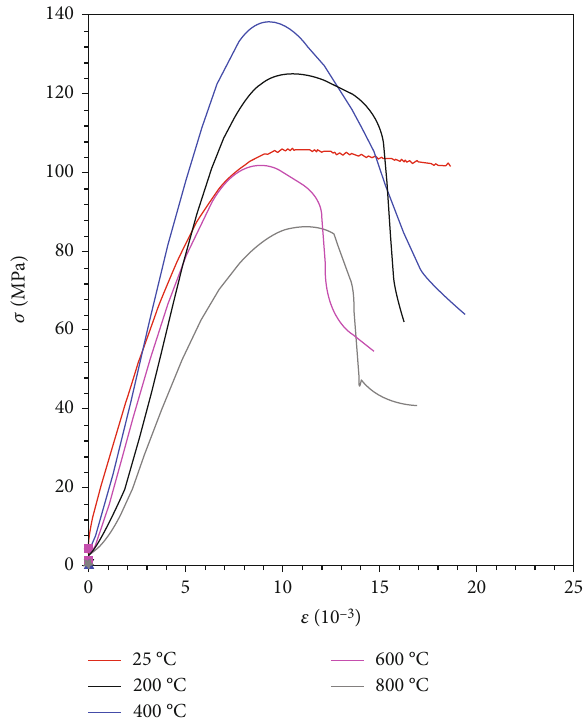
Figure 7: Stress-strain curves of tight sandstones after natural cooling.